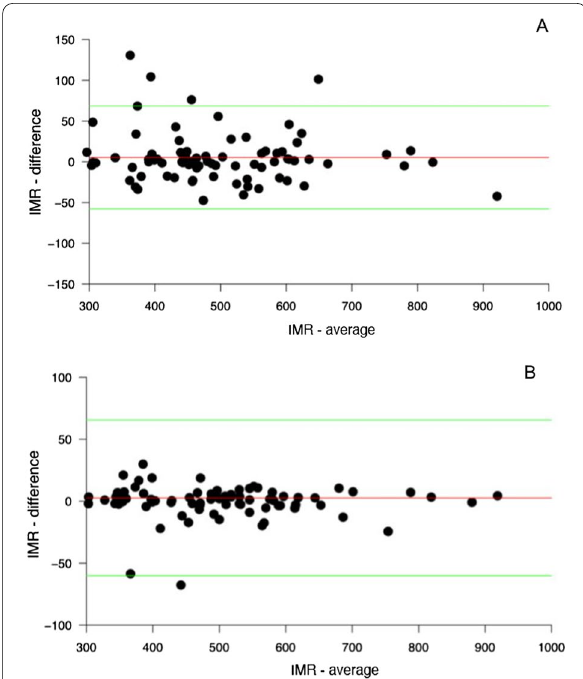
Fig. 3 Comparison of Hounsfield unit (HU) with Bland–Altman analysis of right coronary artery ( a ) and left anterior descendant ( b ), between Reader 1 and Reader 2: red line shows the average of the differences, and green lines show the 95% limits of agreement (LoA)